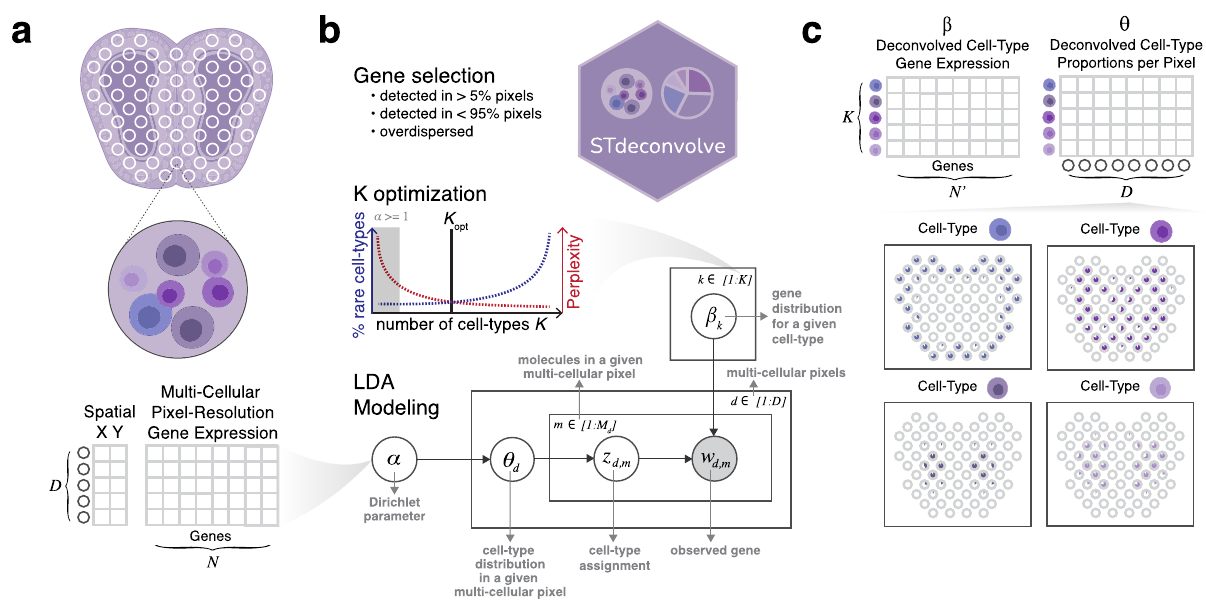
Fig. 1 Overview of STdeconvolve. a STdeconvolve takes as input a spatial transcriptomics (ST) gene counts matrix of D pixels (rows) by N genes (columns). A matrix of spatial coordinates for each of the D pixels can also be used for visualization. b STdeconvolve fi rst feature selects genes for deconvolution, such as genes with counts in more than 5% and less than 95% of the pixels, and overdispersed across the pixels. STdeconvolve then guides the selection of the optimal number of cell types to be deconvolved, K . STdeconvolve fi nally applies LDA modeling. A graph representation of LDA modeling and the parameters to be learned is shown. Shaded circle indicates observed variables and clear circles indicate latent variables. c STdeconvolve outputs two matrices: (1) β , the deconvolved transcriptional pro fi le matrix of K cell types over N ’ feature selected genes, and (2) θ , the proportions of K cell types across the D pixels. The proportions of deconvolved cell types can then be visualized across the